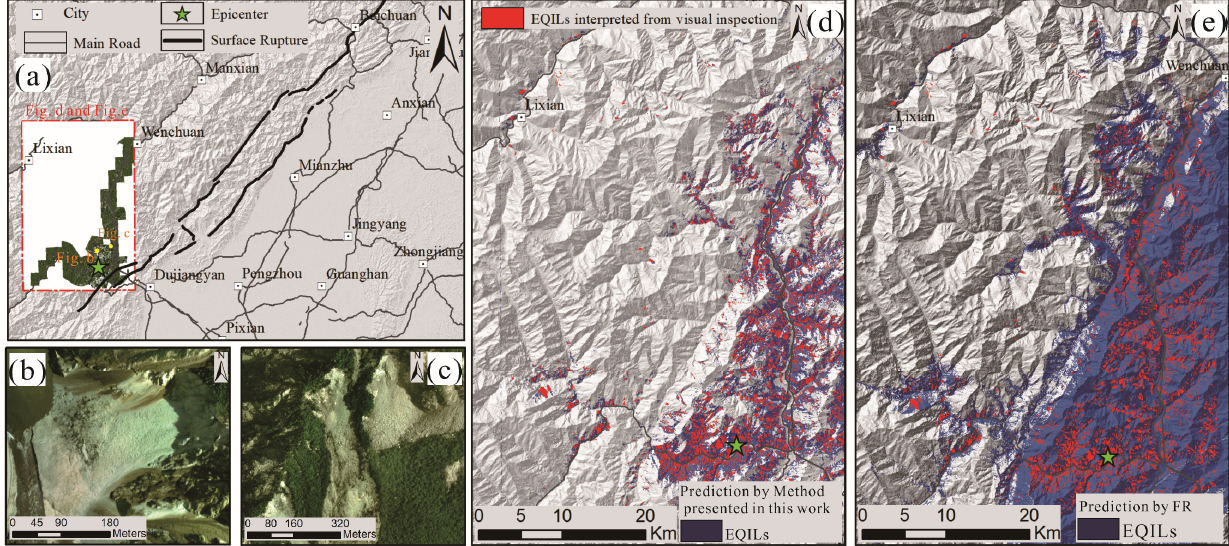
Figure 11. Spatial prediction of EQIL in bedrock: (a) Location of rock EQIL area ( b , c ) The UAV images show two typical EQIL in this area. ( d ) Distribution predicted by proposed method. ( e ) EQIL obtained from FR. The area is along the Dujiangyan-Wenchuan highway.